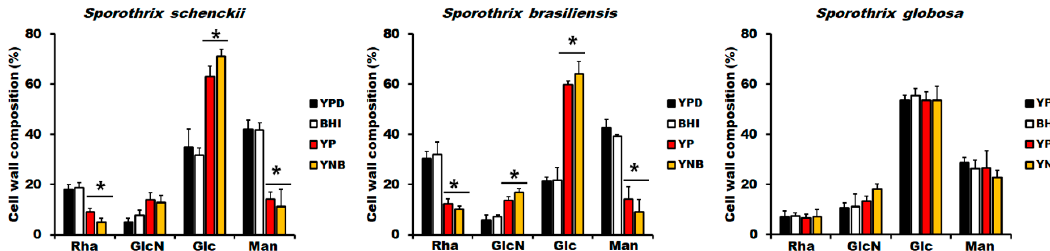
Figure 3. Cell wall composition of Sporothrix schenckii , Sporothrix brasiliensis , and Sporothrix globosa grown in different culture media. Yeast-like cells grown in indicated media were collected, and cell walls were isolated, cleaned, acid-hydrolyzed, and analyzed by high-performance anion-exchange chromatography with pulsed amperometric detection, as described in the Materials and Methods section. Cell walls preparations were from Sporothrix schenckii , Sporothrix brasiliensis , and Sporothrix globosa . Results are the media ± standard deviation from three independent experiments performed by duplicate. * p < 0.05 when compared to the sugar content of YPD- or BHI-grown cells.